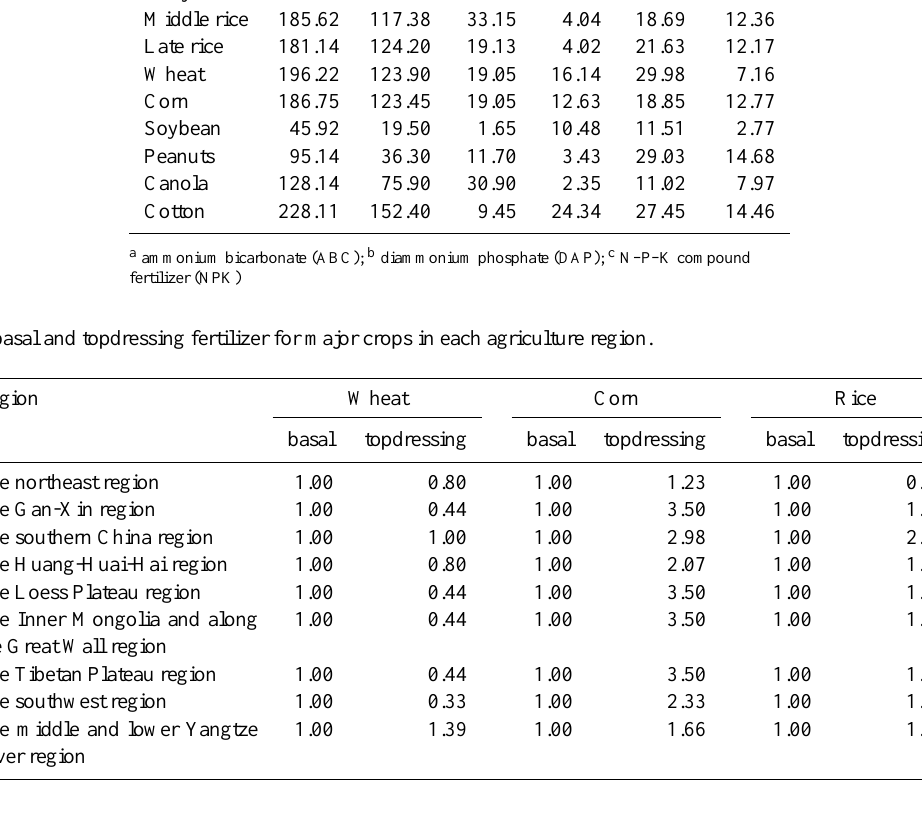
Table 1. The 2011 national-average fertilizer application rate for major crops in China (kgNha − 1 ). Total Urea ABC a DAP b